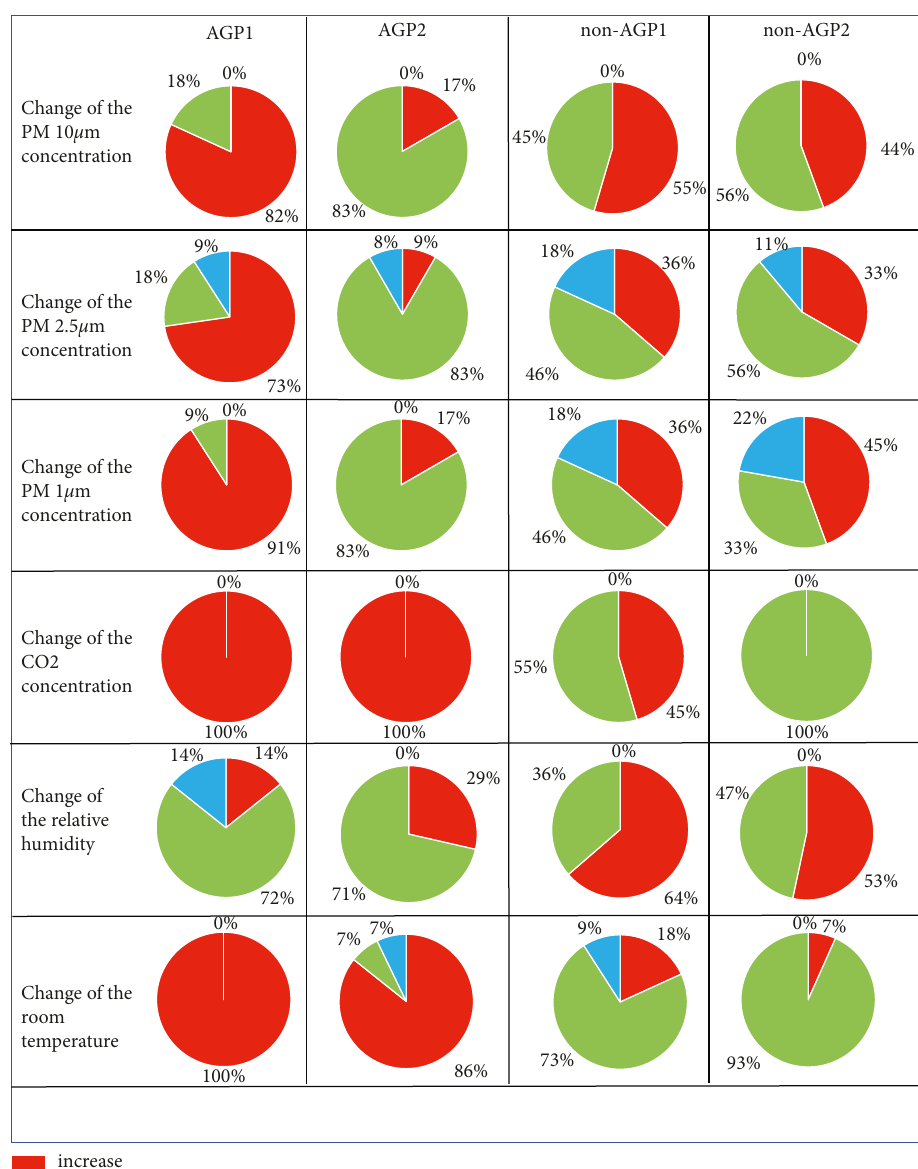
Figure 1: Illustration of the distribution of trends (increasing, stable, and decreasing) per test of AGP versus non-AGP for Δ PM10, Δ PM2.5, Δ PM1, Δ CO 2 , ∆ humidity, and ∆ temperature per hour. CO 2 : carbon dioxide concentration; AGP1: aerosol generated procedure with intraoral high-volume evacuation (HVE); AGP2: aerosol-generated procedure with HVE and extraoral mobile extraoral scavenger; non- AGP1: no aerosol-generated procedure under conditions of technical ventilation; non-AGP2: no aerosol-generated procedure under conditions of open windows; hum: relative humidity; temp: room